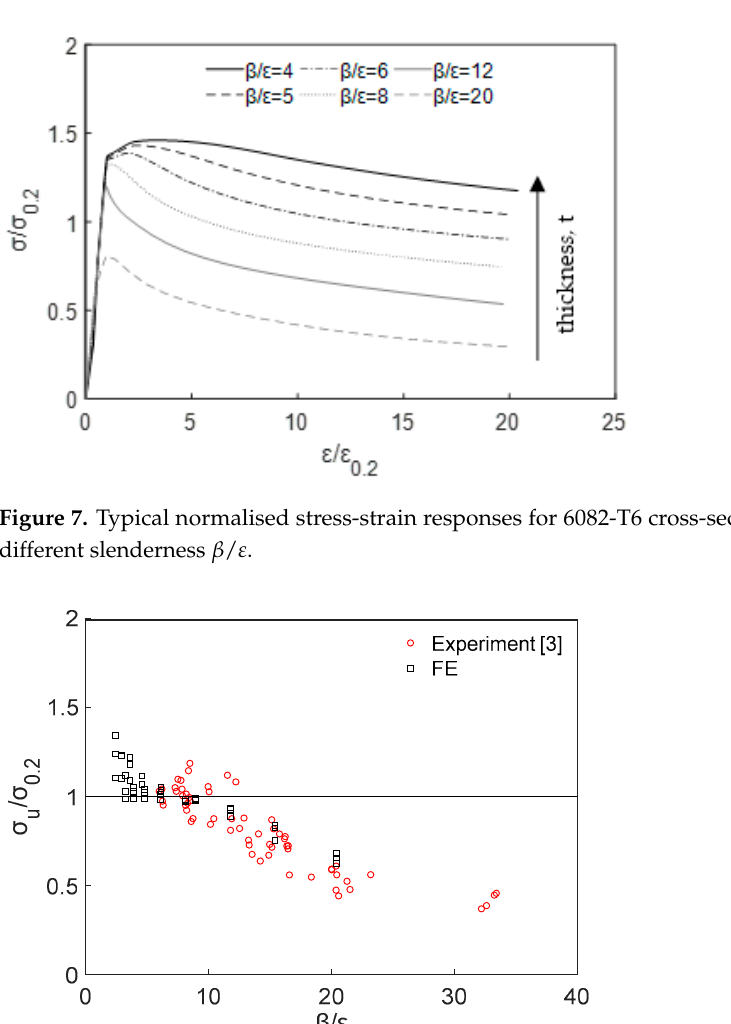
Figure 6. Typical normalised stress-strain responses for 6082-T6 cross-sections with thickness t = 10 mm and different aspect ratios a / b .